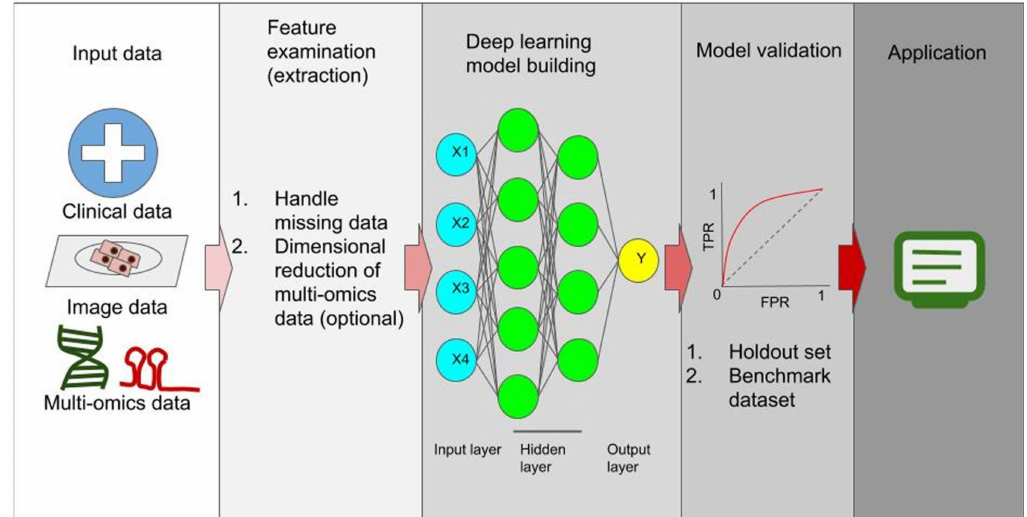
Figure 1. Workflow of building deep learning models for cancer prognosis prediction. The sources of input data include clinical data which could be text data and / or structured data (numeric and / or categorical data), clinical images which could be tissue slides in H&E staining or immune-histological staining. MRI, CT, etc, and genomic data which could be expression data (i.e., mRNA expression